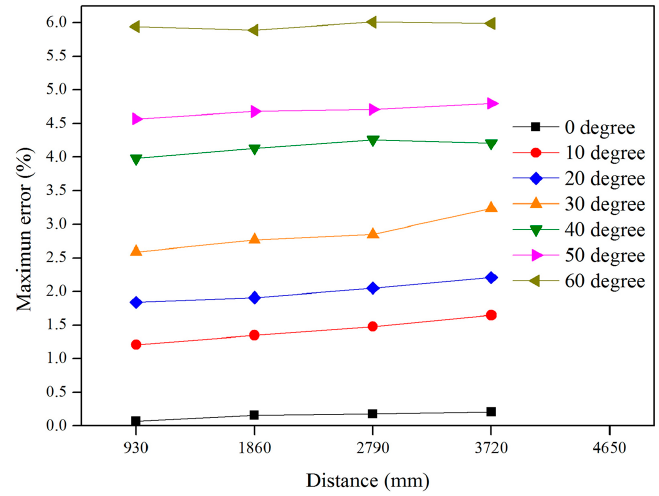
Figure 7. Maximum scaling factor error between SF 1 and SF 2 in accordance with the distance and the angle.